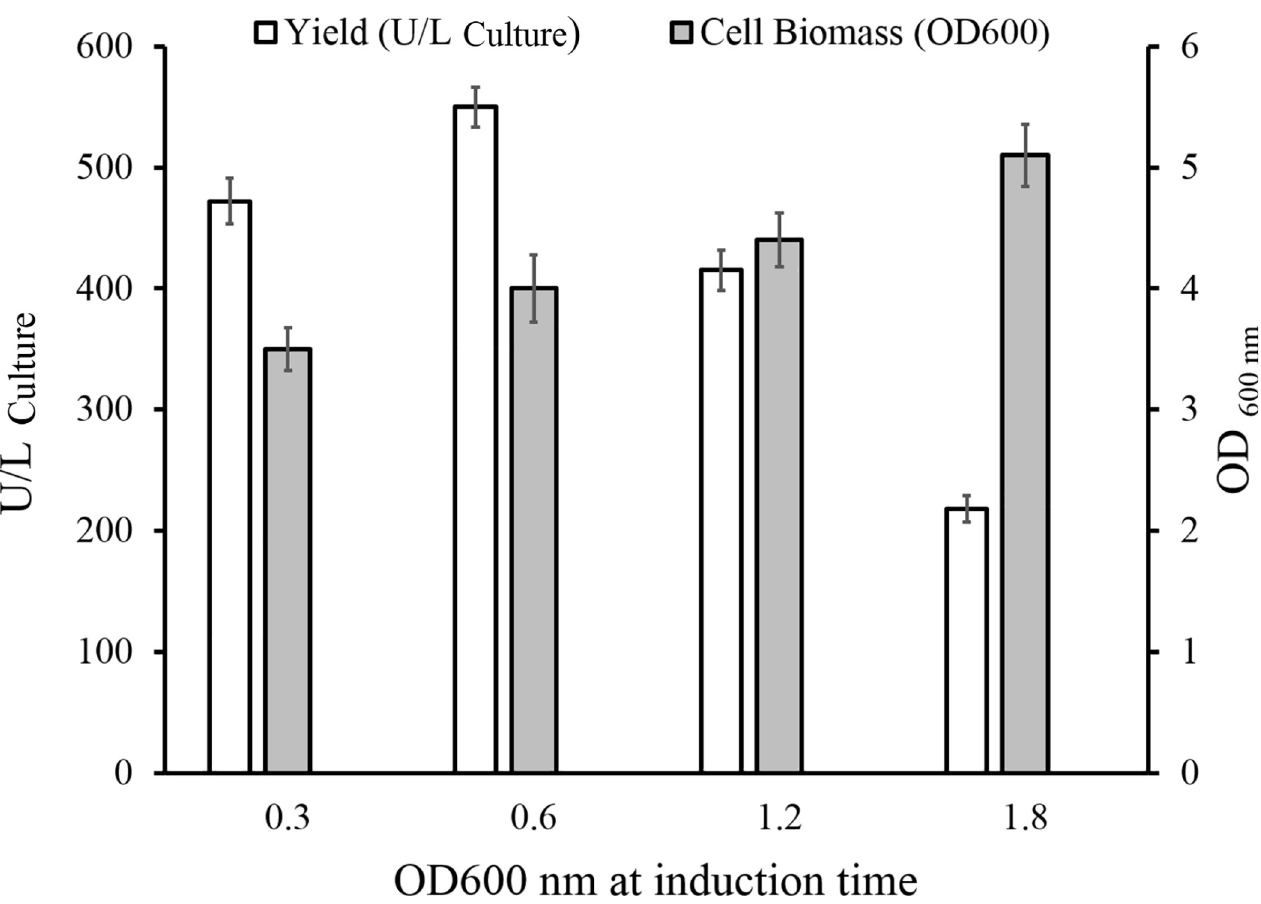
Fig 3. The impact of pre-induction growth on the cholesterol oxidase expression and final growth rate. Protein expression was induced in various bacterial growth phases (OD 600nm = 0.3, 0.6, 1.2, and 1.8). Total enzyme activity and final bacterial growth rate were measured after further incubation for 6 h at 37˚C.